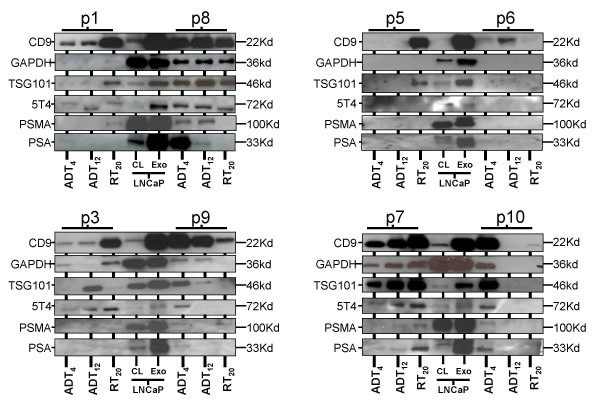
Characterising exosomes from PCa patients. Urinary exosomes (5 μg/well), isolated from 8 PCa patients (at ADT4, ADT12 or RT20), were subject to western blot analyses with a panel of antibodies as indicated. Whole cell lysates (CL) or exosomes (Exo) of LNCaP (5 μg/well) was included on each gel as positive controls.